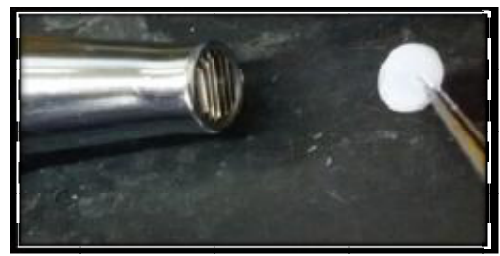
Figure 2 : Disc dry